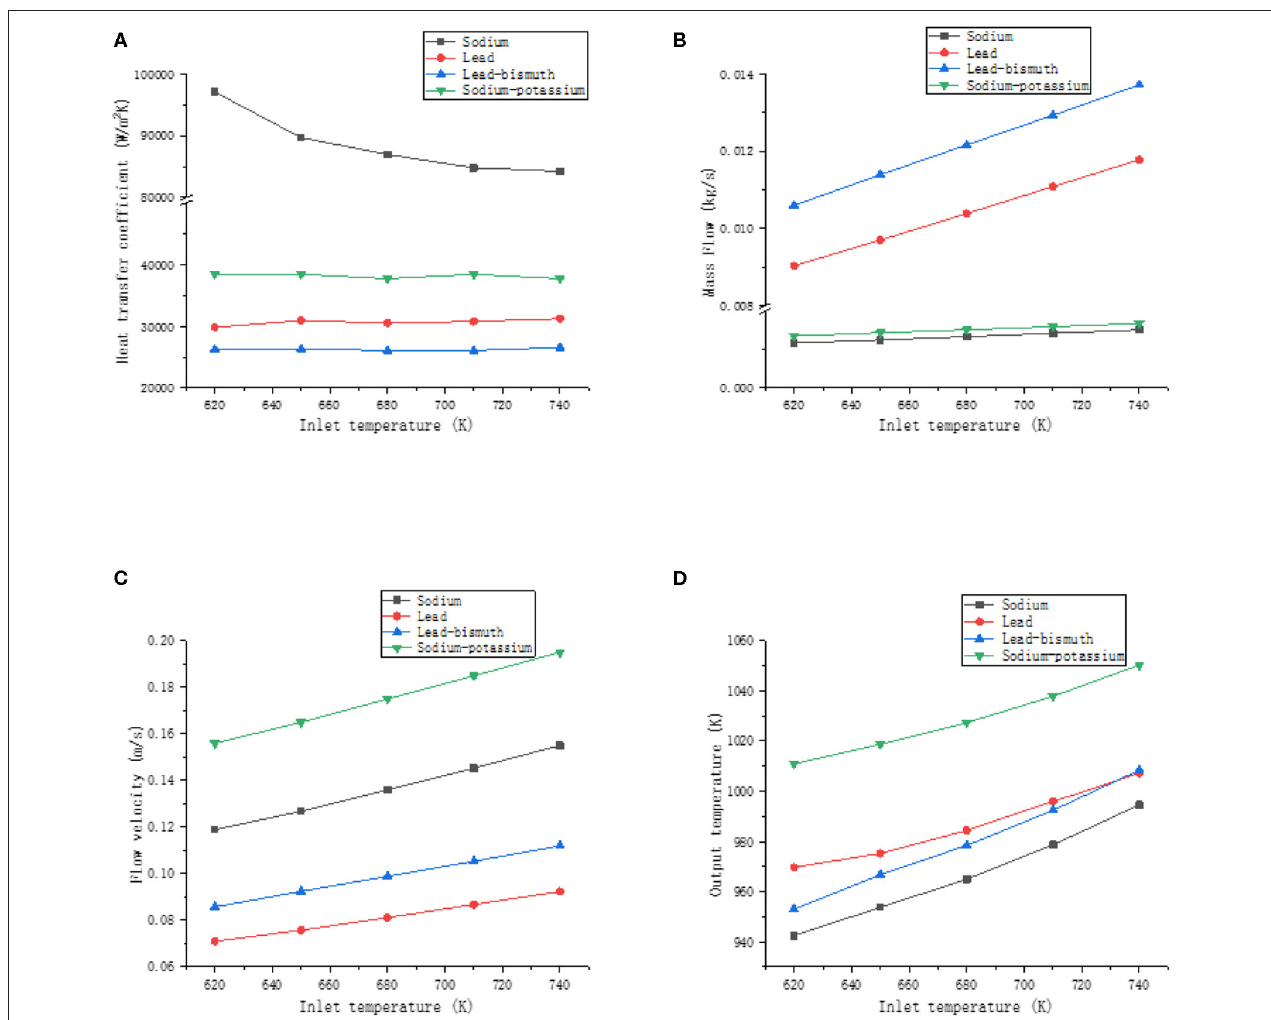
FIGURE 9 | The effect of inlet temperature. (A) Effect of inlet temperature on heat transfer coefficient, (B) effect of inlet temperature on mass flow, (C) effect of inlet temperature on flow velocity, and (D) effect of inlet temperature on outlet